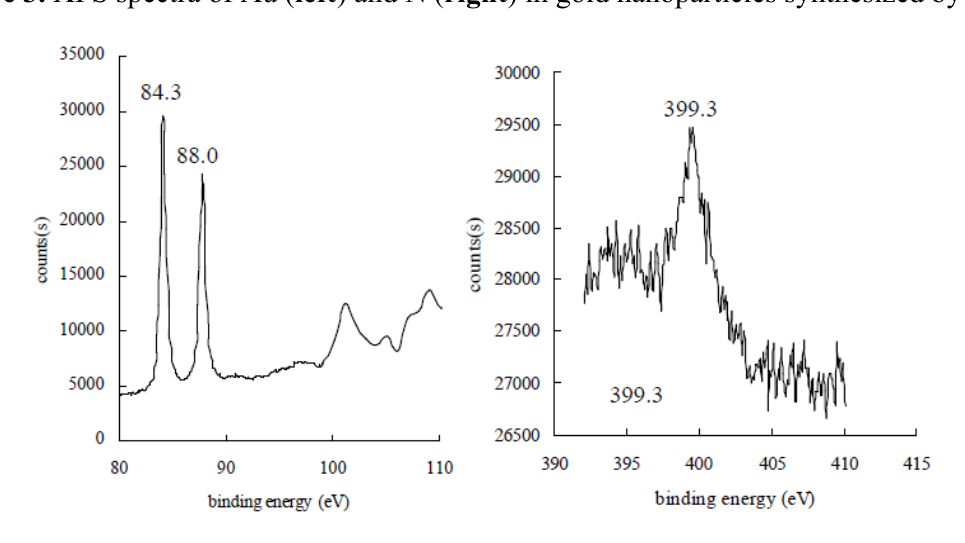
Figure 4. Emission spectra of Mb in aqueous solution with an excitation wavelength